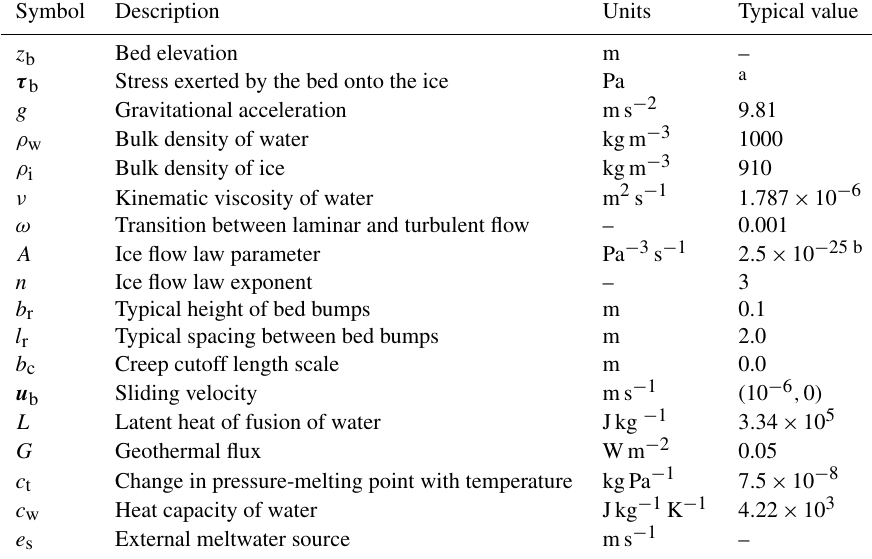
Table 1. List of constants and parameters employed in SUHMO. a The expression for the basal drag follows a modified Weertman law (Weert- N , where the value for C b is typically set to 400s 2 m − 2 . b This value is chosen in accordance with a closure of the form man, 1957): C b u 2 b AlN n (de Fleurian et al.,